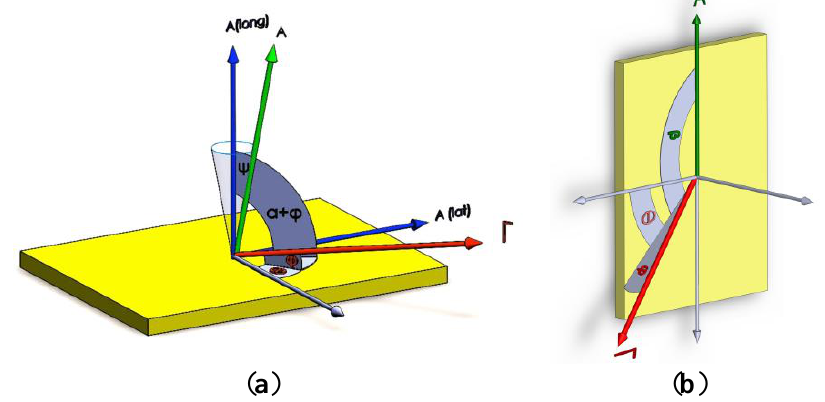
Figure 9. Steady state load applied on the crystal installed on the host vehicle. ( a ) Horizontally; ( b )